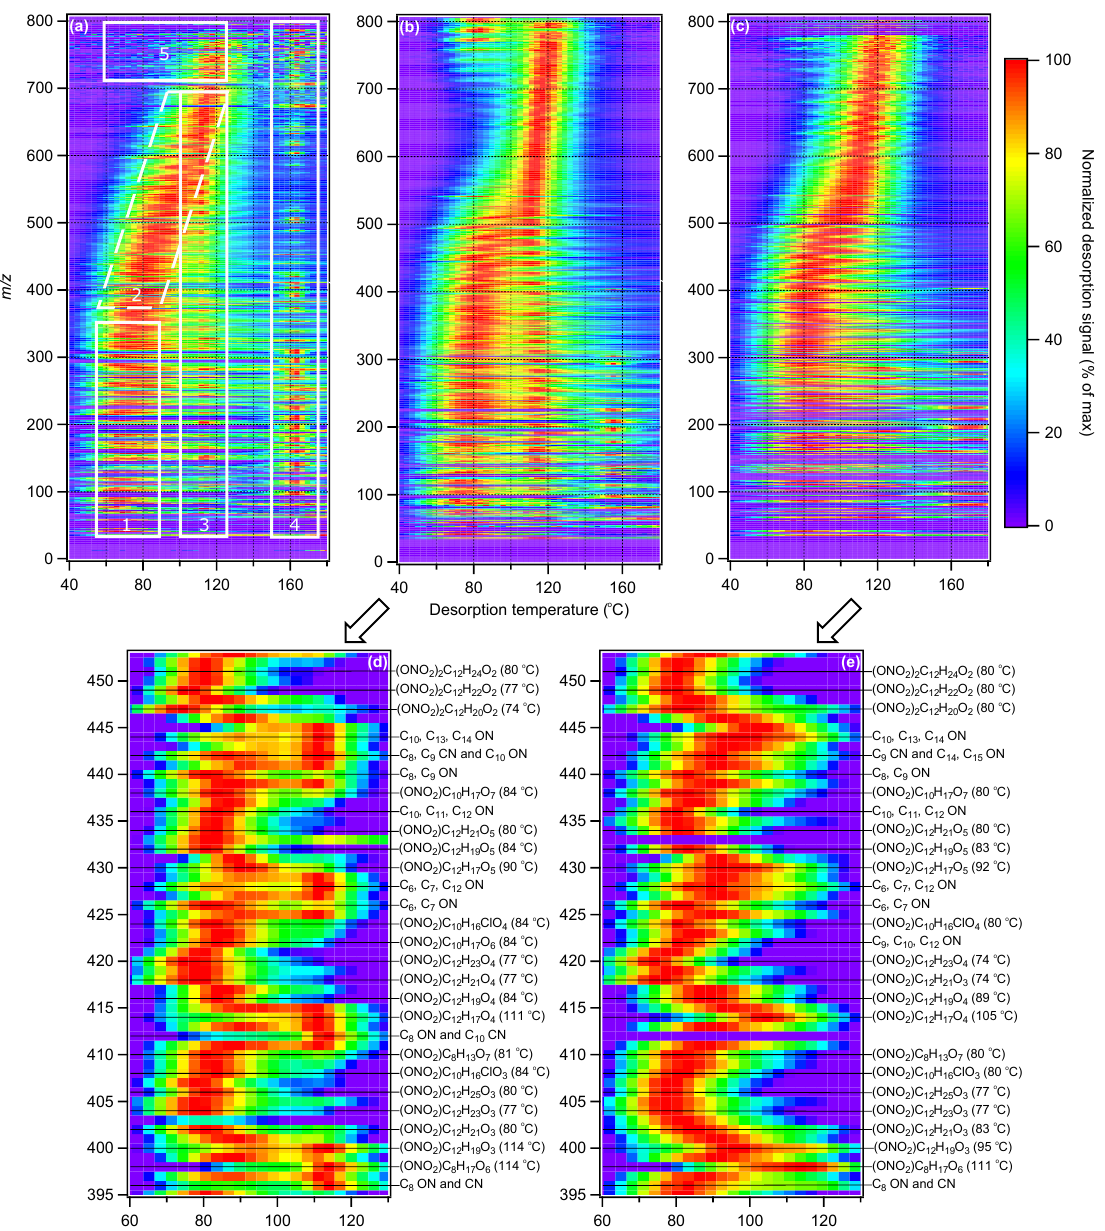
Figure 5. Comparison of two-dimensional thermograms for (a) octane–Cl SOA under low RH from Exp. 3, (b) dodecane–Cl SOA under low RH from Exp. 11, and (c) dodecane–Cl SOA under high RH (67%) from Exp. 12. The color represents the ion intensity at a m/z as a percentage of the maximum desorption signal observed at that m/z . Different thermal desorption regions in (a) are dominated by (1) low- temperature thermal decomposition products and nonadducts (2) monomers (3) oligomers and their decomposition products and (4) thermal decomposition of ammonium sulfate or extremely low-volatility compounds. Region (5) is unresolved but appears to be thermally unstable oligomers. Region (2) and (3) can overlap, as shown in (d) for (b) and as shown in (e) for (c) . At each nominal m/z , only the dominant ion is labeled in (d) and (e) . If multiple ions of similar intensity were present, only general descriptions are given in the annotations, where ON stands for organonitrate and CN stands for chloronitrate. Nonnitrated organic ions were observed but not labeled because they were positioned between more intense organonitrates at neighboring m/z coordinates. T max values are included in parenthesis. Increasing the RH suppressed oligomer formation, enhancing the monomer features in (c) and (e) when compared with (b) and (d) . The m/z values shown includes the chemical ionization reagent I − ( m/z